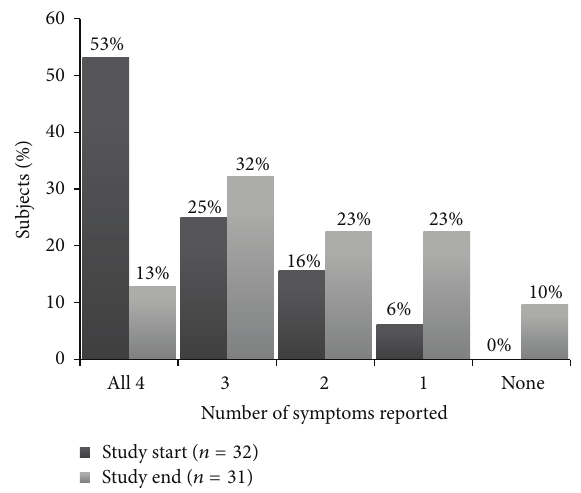
Figure 1: Percent of patients reporting different numbers of symp- toms at study start and study end. Study start was 1.0 days (median) after admission; study end was 1.0 days (median) before discharge. Symptomsassessedwereshortnessofbreath,fatigue,orthopnea,and edema.